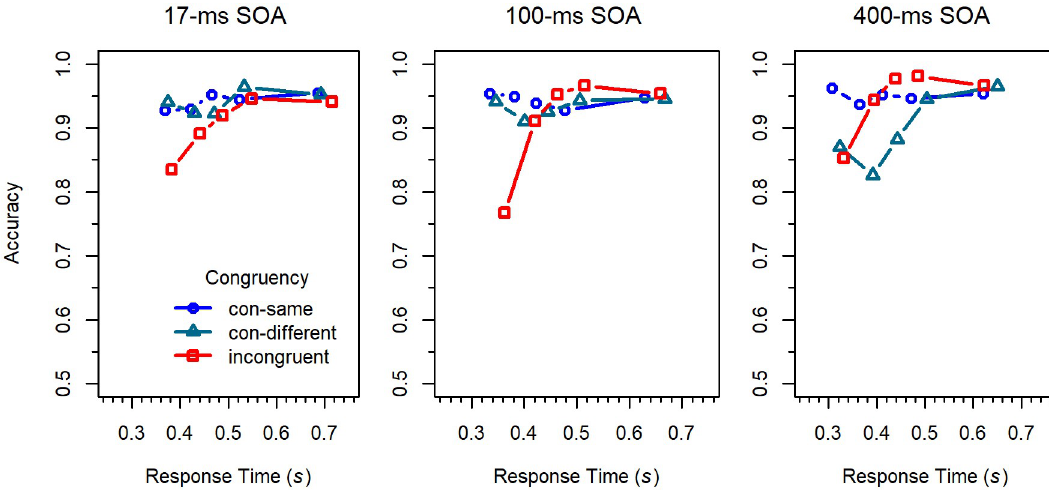
Fig 5. Conditional accuracy functions for the different conditions in Experiment